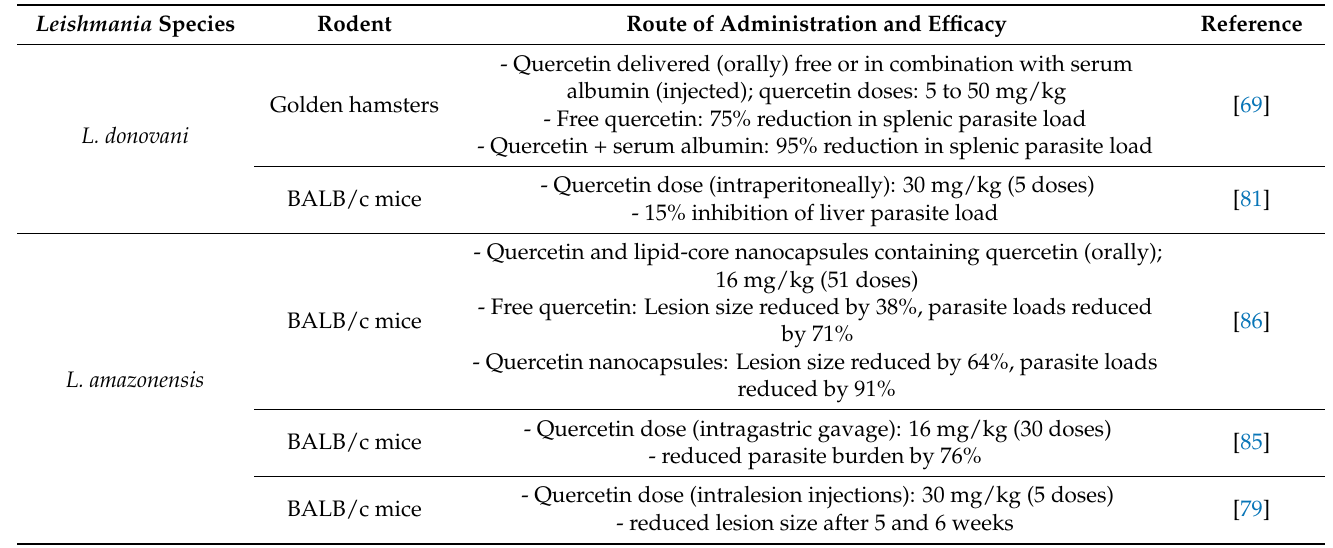
Table 5. In vivo efficacy of